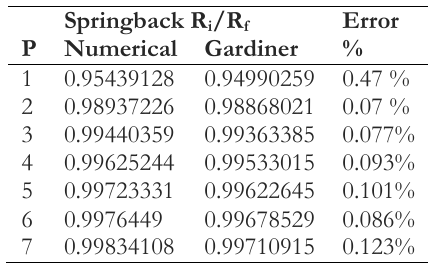
Table 7. Gardiner model error versus numerical simulation for 1.5 mm thickness.